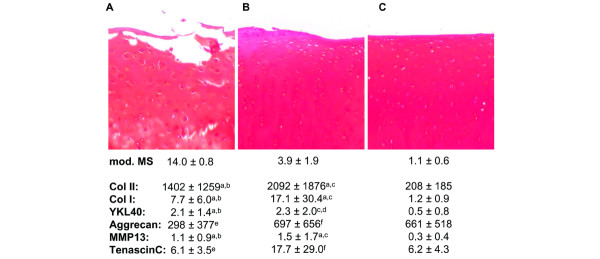
No correlation of molecular changes to the histological scoring. In order to directly correlate a certain histological outcome with gene expression independent of the study group or the location, samples adjacent to sections with (a) the highest (n = 8) or (b) the lowest (n = 7) modified Mankin score (mod. MS) in the anterior cruciate ligament transection-treated group were selected and were compared with (c) seven normal control samples with the lowest mod. MS in the study. Top, representative histological sample (magnification, 40 ×); bottom, corresponding mean and standard deviation of the mod. MS and of gene expression levels (% GAPDH expression). col., collagen type. a P < 0.05 versus (c), b no significant difference versus (b), c no significant difference versus (a), d P = 0.052 versus (c), e no significant difference versus (b) and (c), f no significant difference versus (a) and (c).